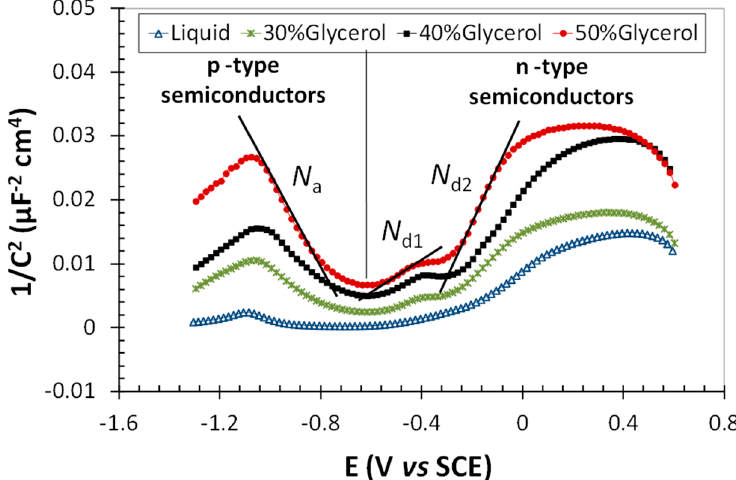
Figure 6. Examples of the Mott–Schottky curves obtained in the liquid and gel electrolytes with 1% KClO 4 .